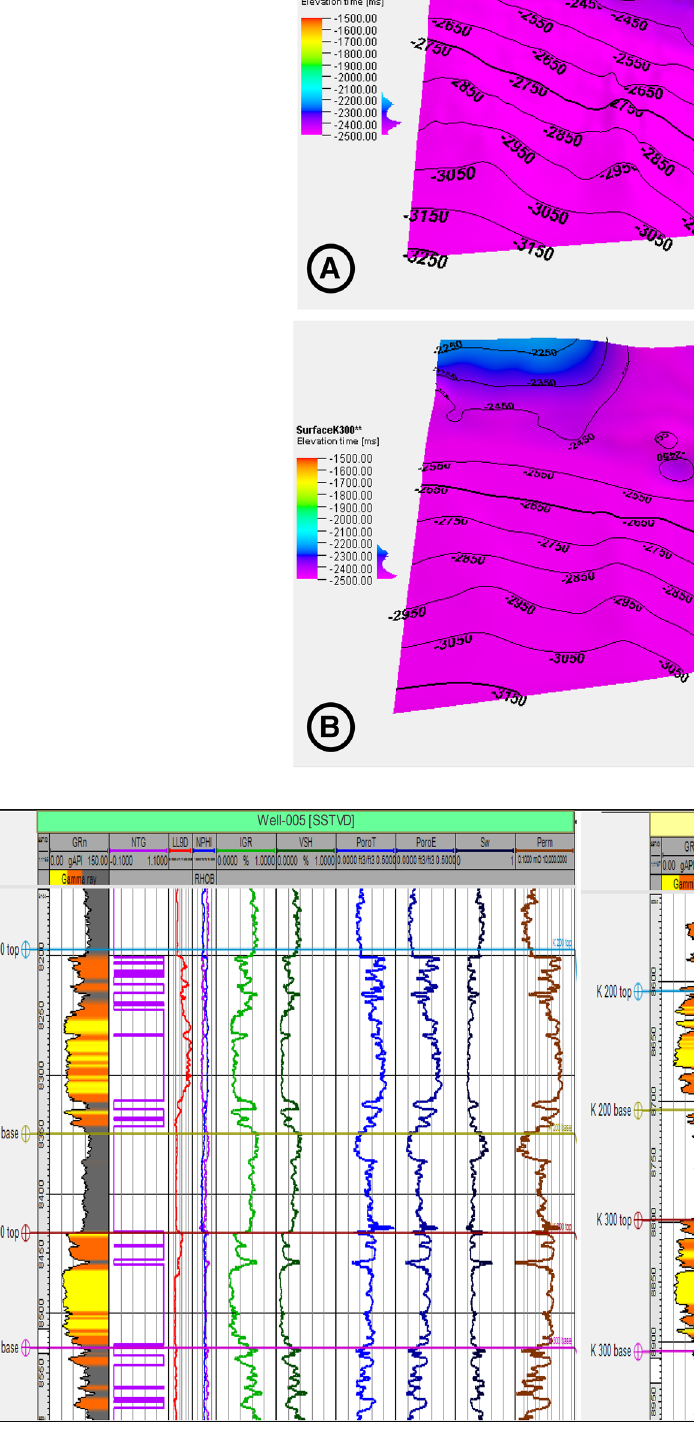
Fig. 8 Sample gamma-ray logs and logs of estimated petrophysical properties, i.e. net-to-gross, total porosity, effective porosity, water saturation and